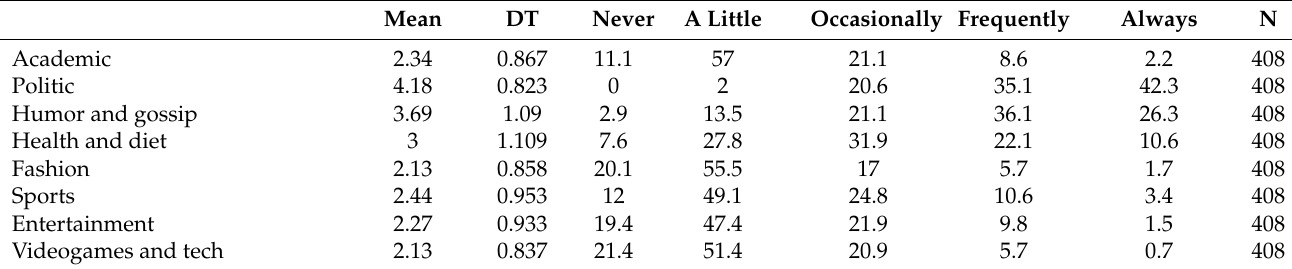
Table 7. Basic statistics for variable (V 11 ): Which contents do you perceive to be more related with fake news? Own elabora- tion.